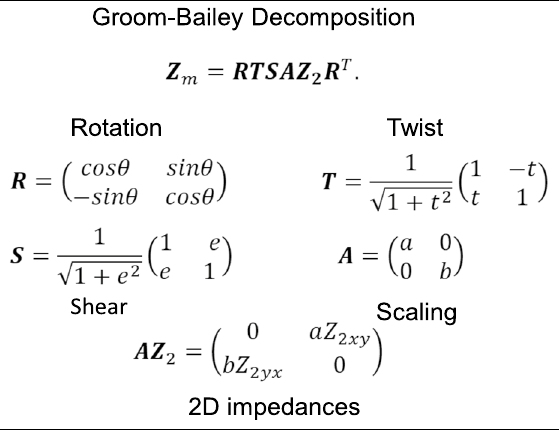
Table 1 The measured impedance tensor is represented as Z m